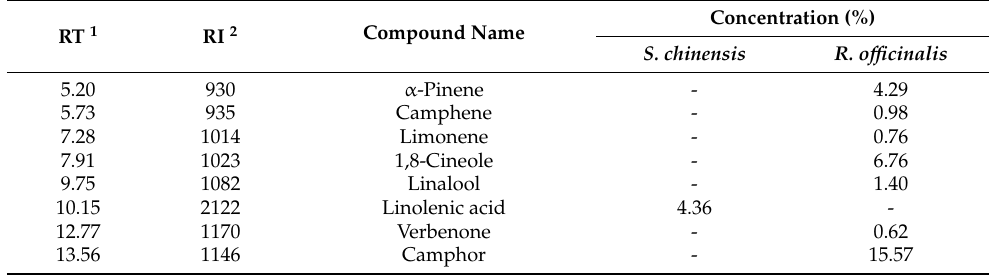
Table 1. Chemical compositions identified in Rosmarinus officinalis and Simmondsia chinensis botanical oils. RT